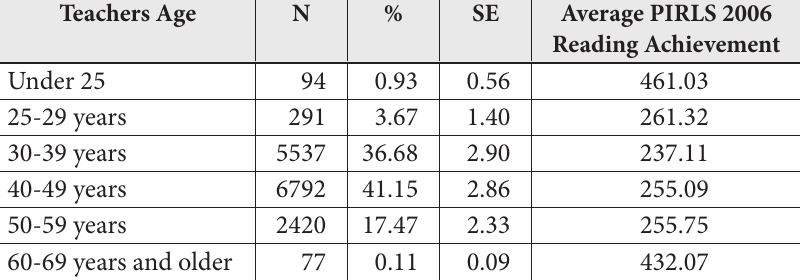
Table 1: Average PIRLS 2006 achievement for teachers’ age groups